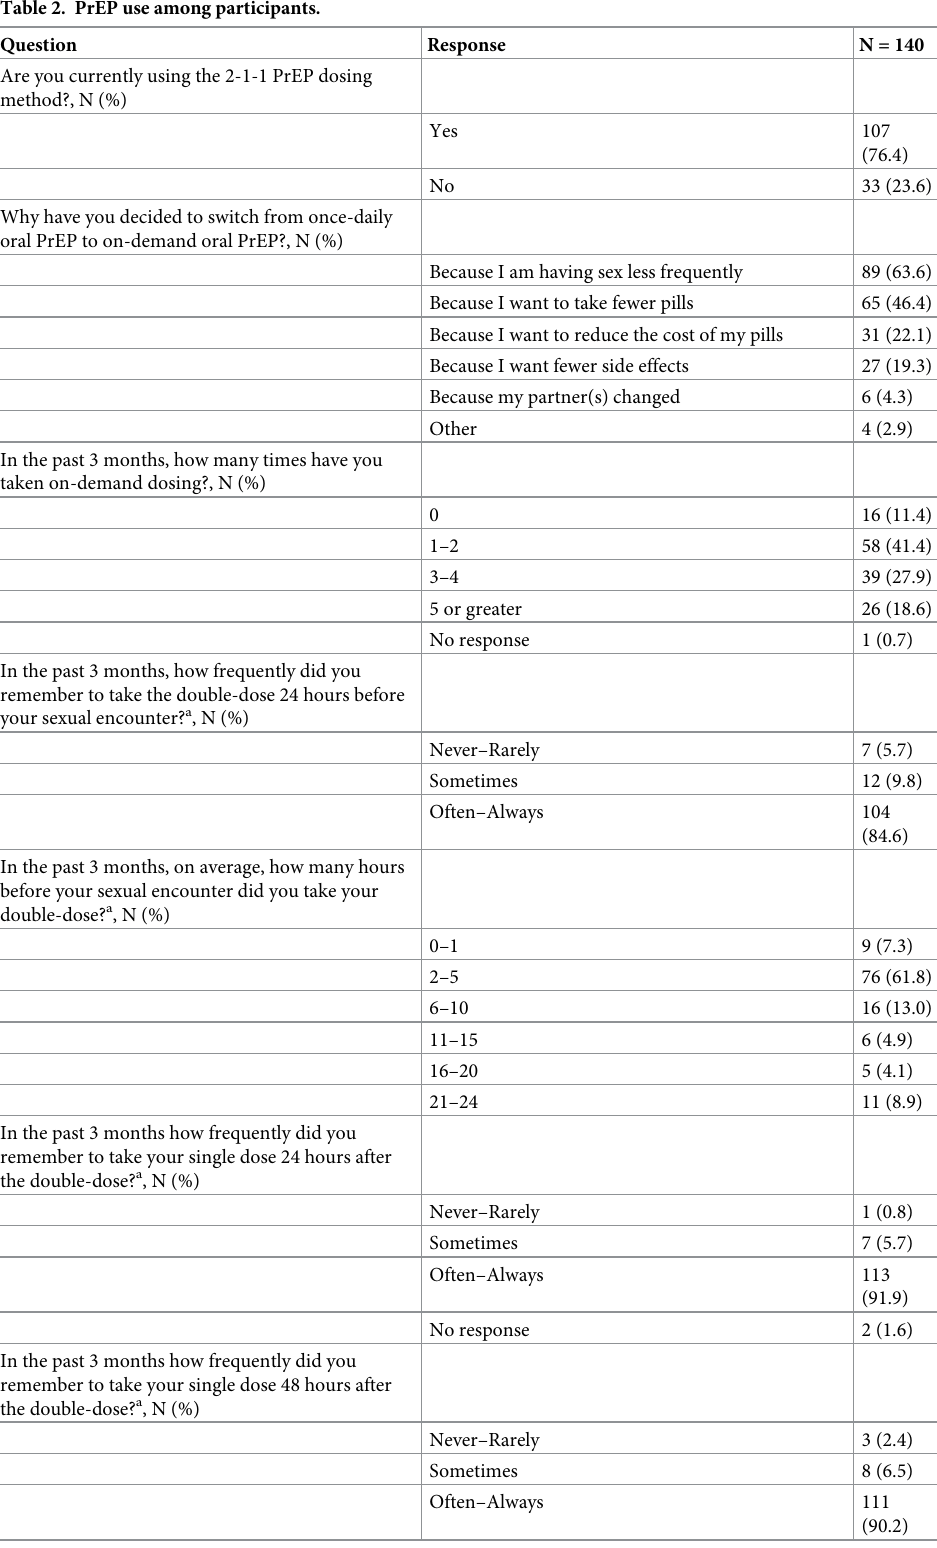
Table 2. PrEP use among participants. Question